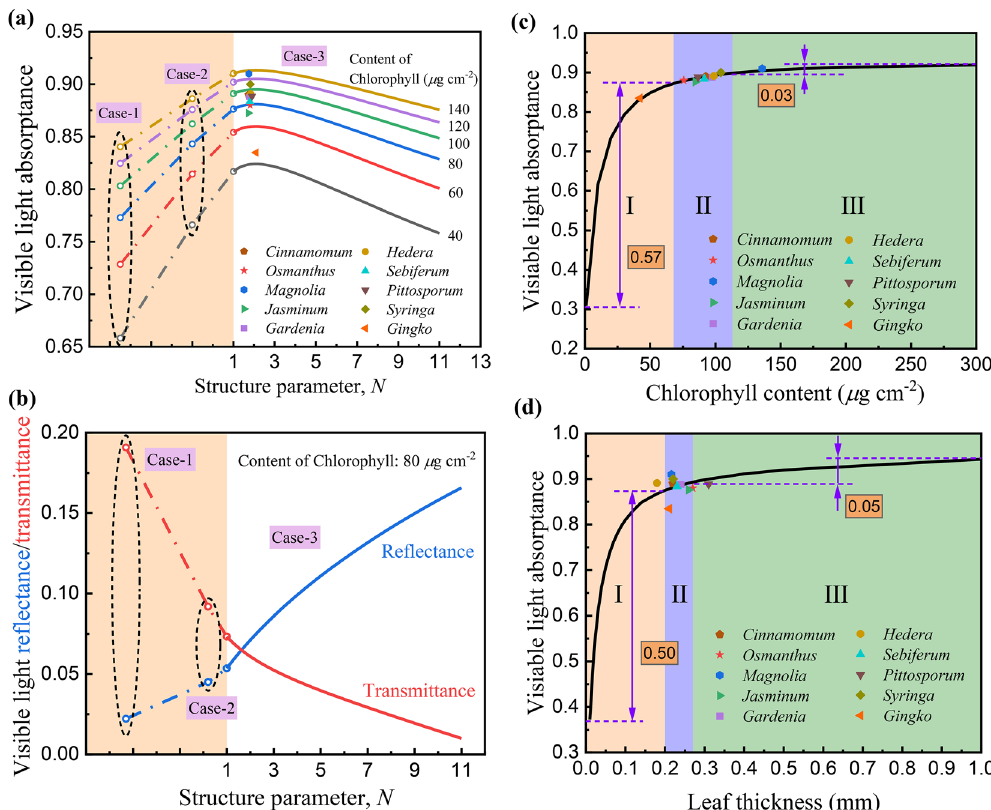
Figure 4. ( a ) Calculated visible light absorptance of leaves with different structures and chlorophyll contents. For the marked points of the natural leaves, the structure parameters were inversed with the radiation model, while the visible light absorptaces were measured. ( b ) Calculated visible light reflectance and transmittance of leaves with different structures. The chlorophll content was set as 80 μg cm -2 . ( c ) Calculated visible light absorptance of natural leaves with different chlorophyll contents. ( d ) Calculated visible light absorptance of natural leaves with different leaf